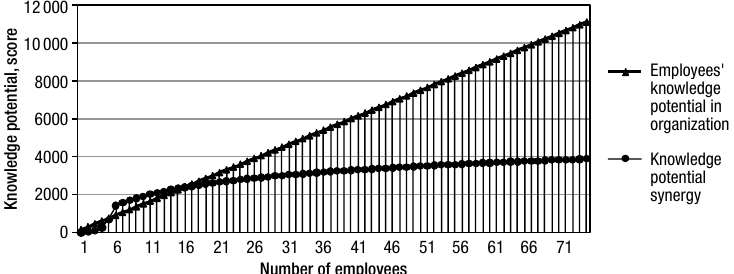
Fig. 5. Comparison of employees’ knowledge potential and knowledge potential synergy in organization (when P